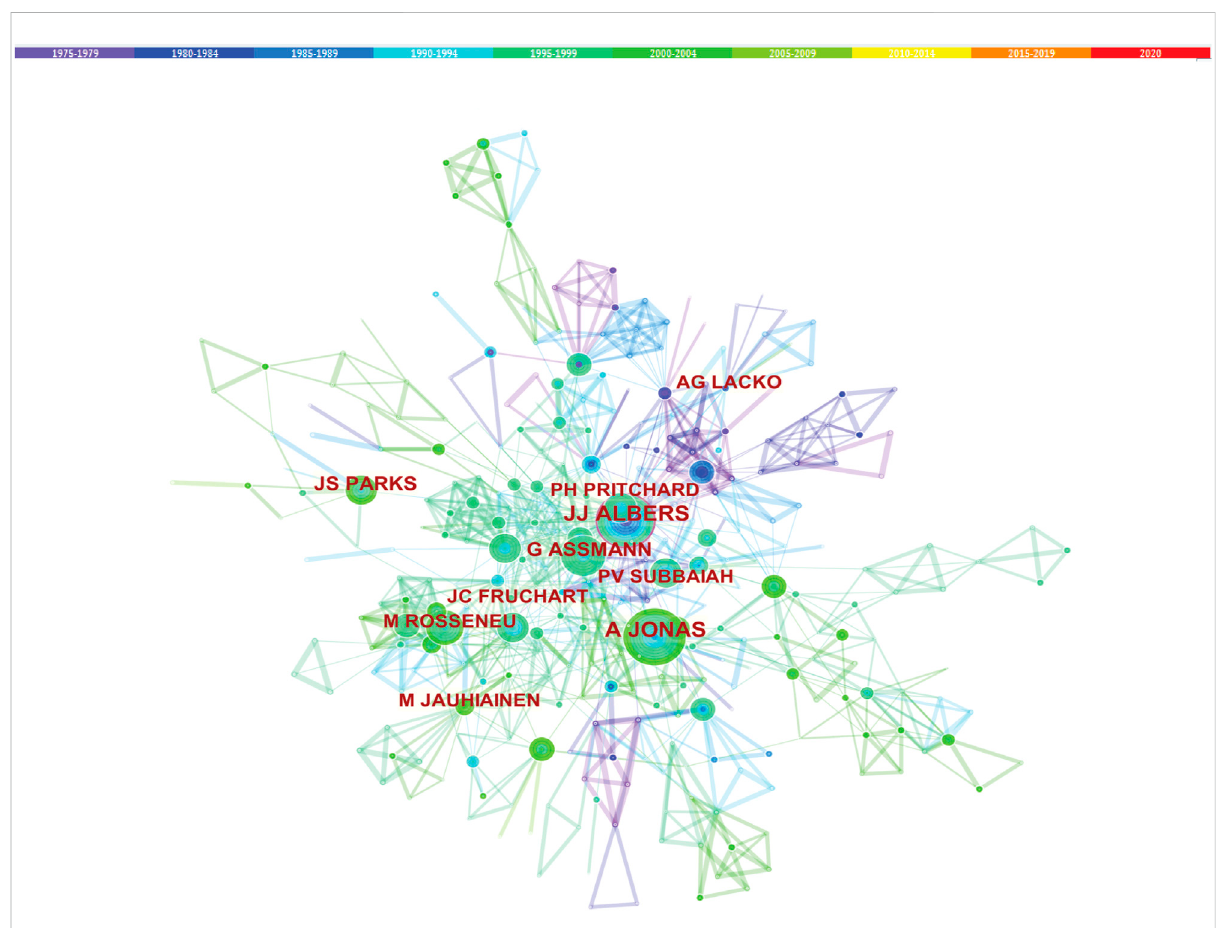
FIGURE 6 Co-authorship of LCAT-related studies. The co-authorship network that works on LCAT.